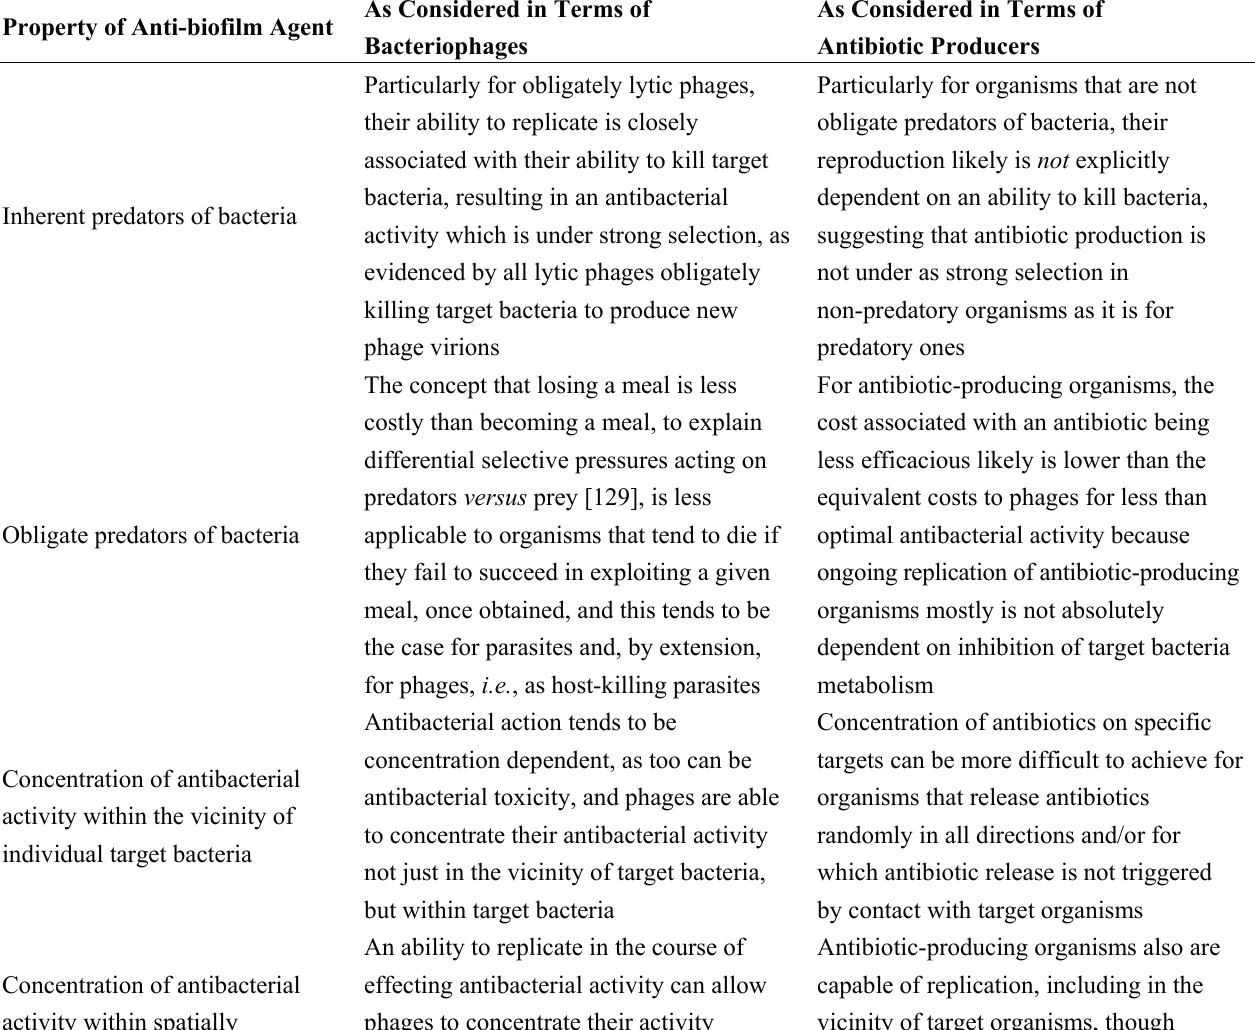
Table 3. Phages as antibacterial or anti-biofilm agents relative to producers of antibiotics. Property of Anti-biofilm